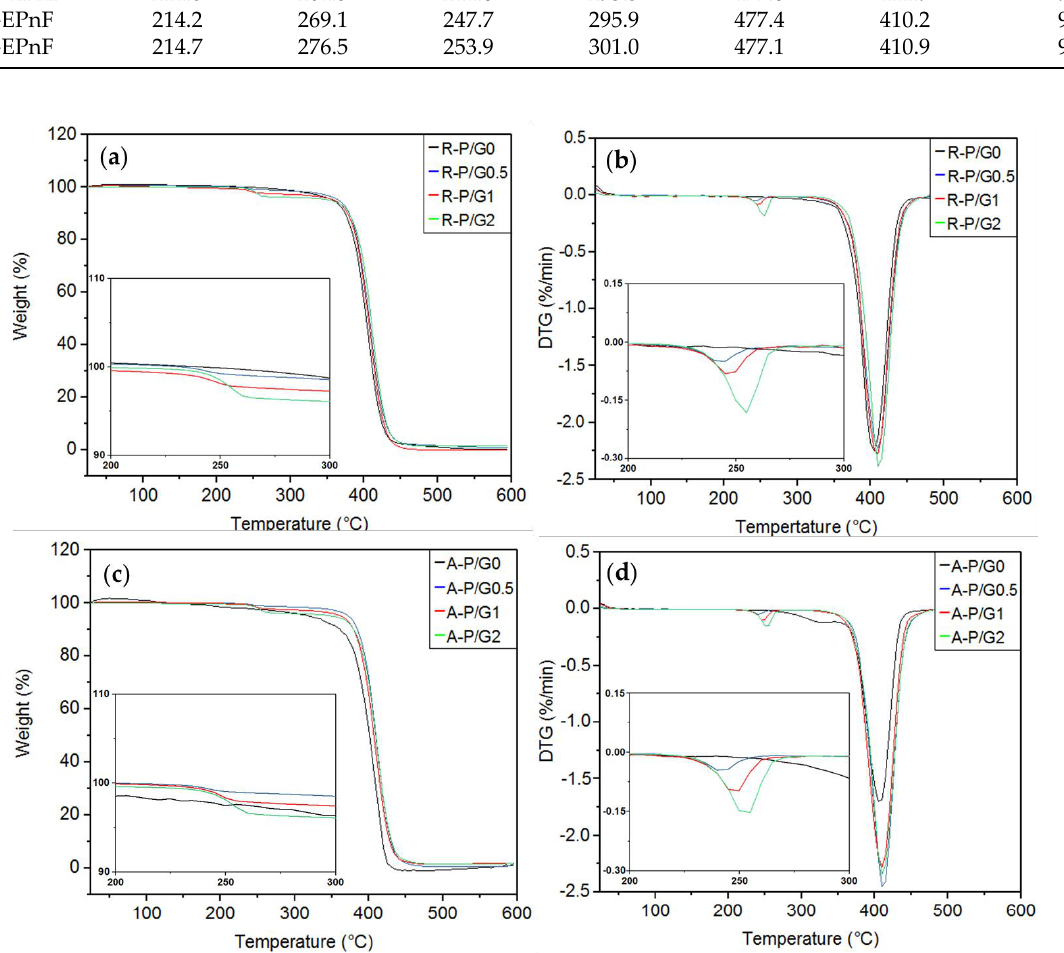
Figure 12. TGA and DTG curves for the R-P/G-EPnF and A-P/G-EPnF meshes. ( a ) TGA of R-P/G-EPnF, ( b ) DTG of the R-P/G-EPnF meshes, ( c ) TGA of the A-P/G-EPnF meshes, and ( d ) DTG of A-P/G-EPnF.